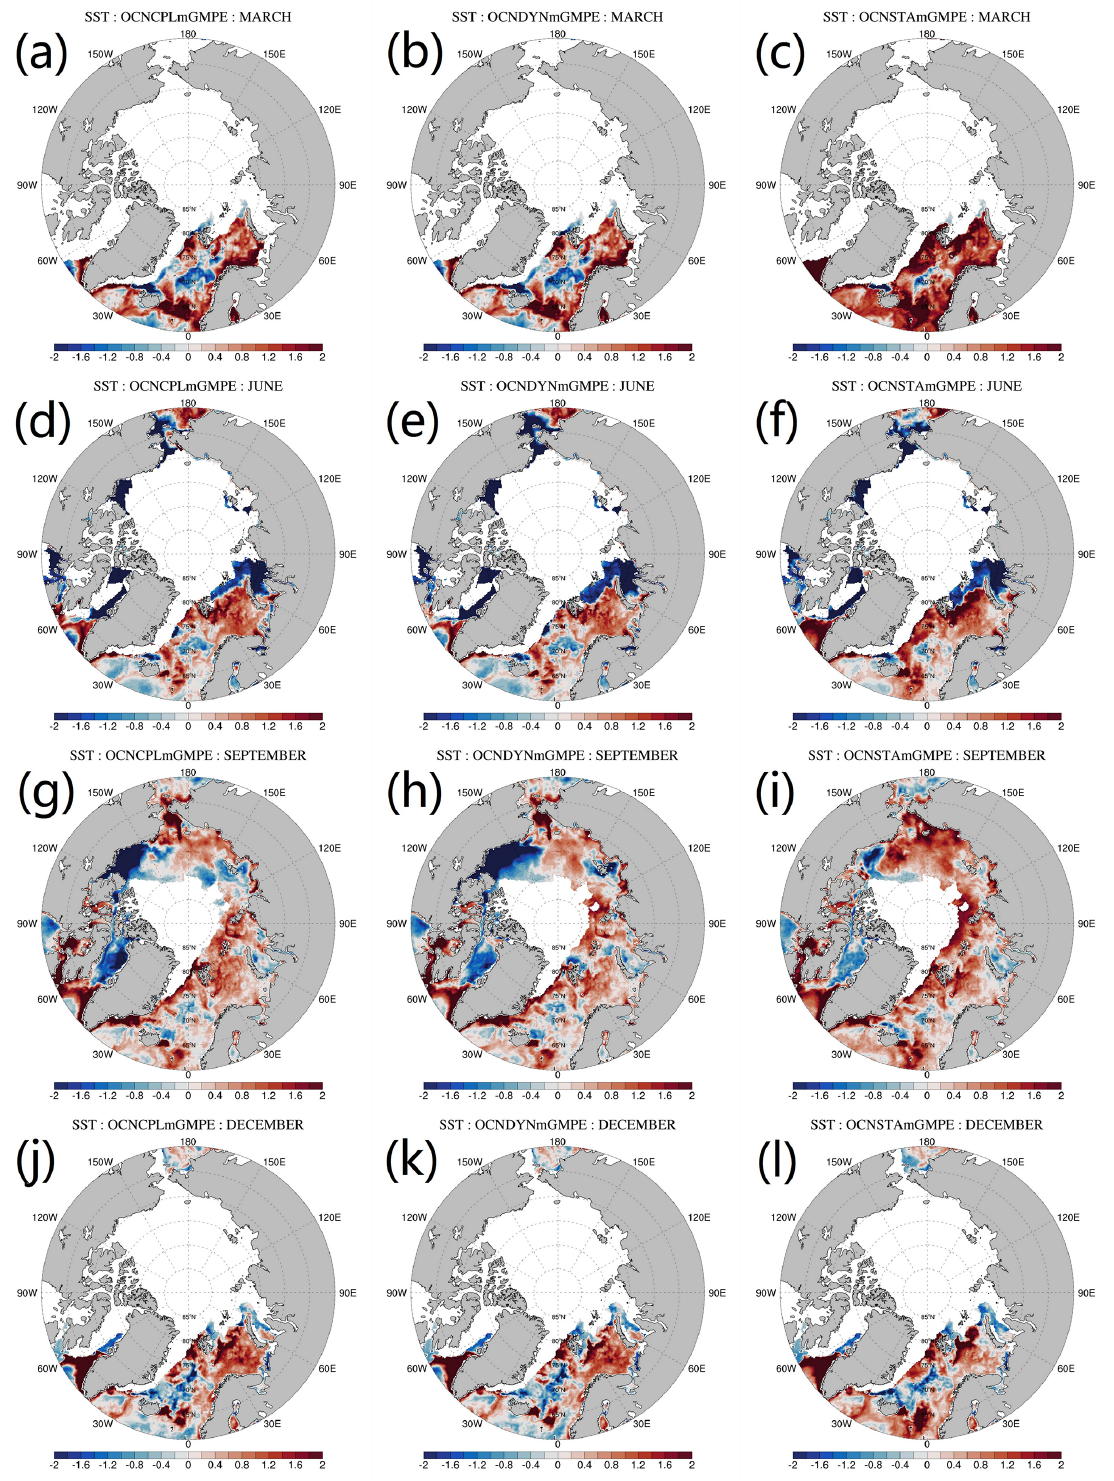
Figure 15. Deviation of the modeled monthly mean SST and the GMPE SST data. From top to bottom panels show the March, June, September and December SST deviation, respectively. From left to right panels show the SST of the OCNCPL run, the OCNDYN run and the OCNSTA run, respectively. GMPE: Group for High-Resolution Sea Surface Temperature Multi-Product